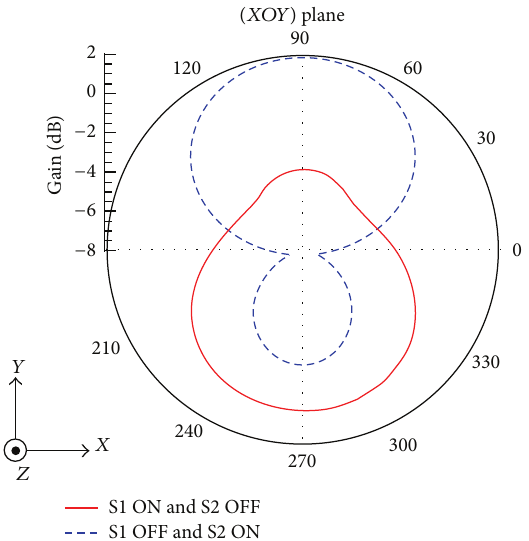
Figure 5: Simulated radiation patterns of the single NFRP element reconfigurable antenna in the ( 𝑋𝑂𝑌 ) plane. State 1 (red) at 𝑓 𝑅 = = 1.72 GHz. 1.55 GHz and State 2 (blue) at 𝑓 𝑅